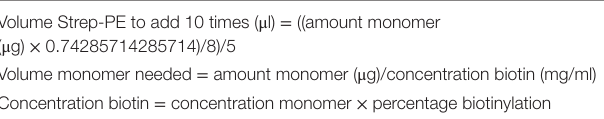
tAbLe 4 | Formula for streptavidin-PE volume calculation for tetramerization of biotinylated monomers. Volume Strep-PE to add 10 times ( μ l) = ((amount monomer